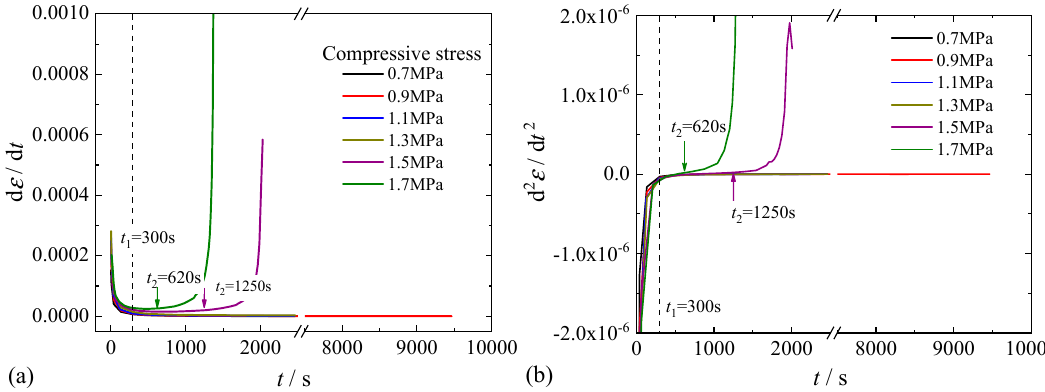
Figure 9. Creep rate curves ( a ) and creep acceleration curves ( b ) of asphalt mixture under various compressive stress levels.